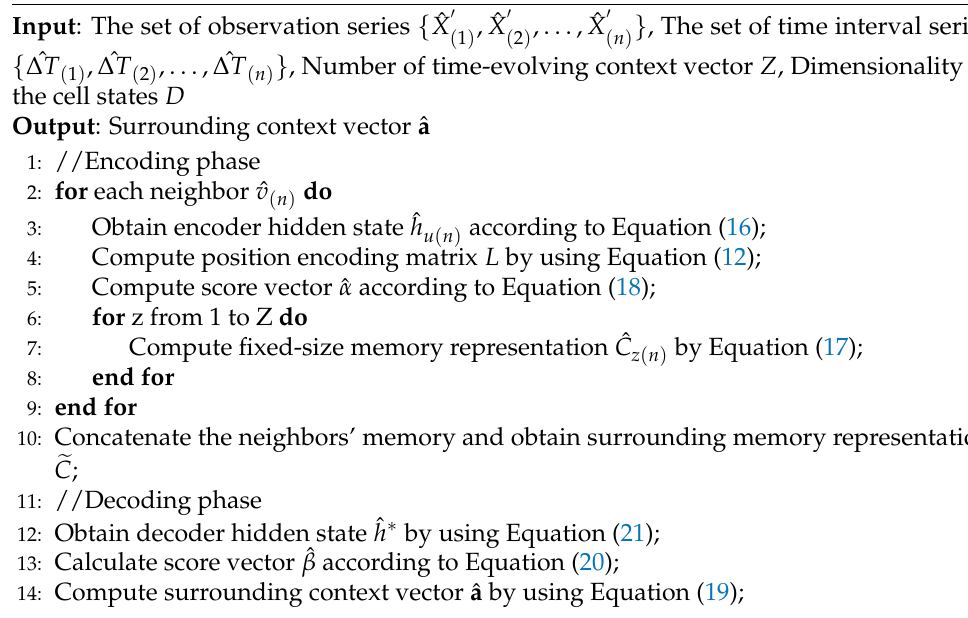
Algorithm 2 Surrounding context vector